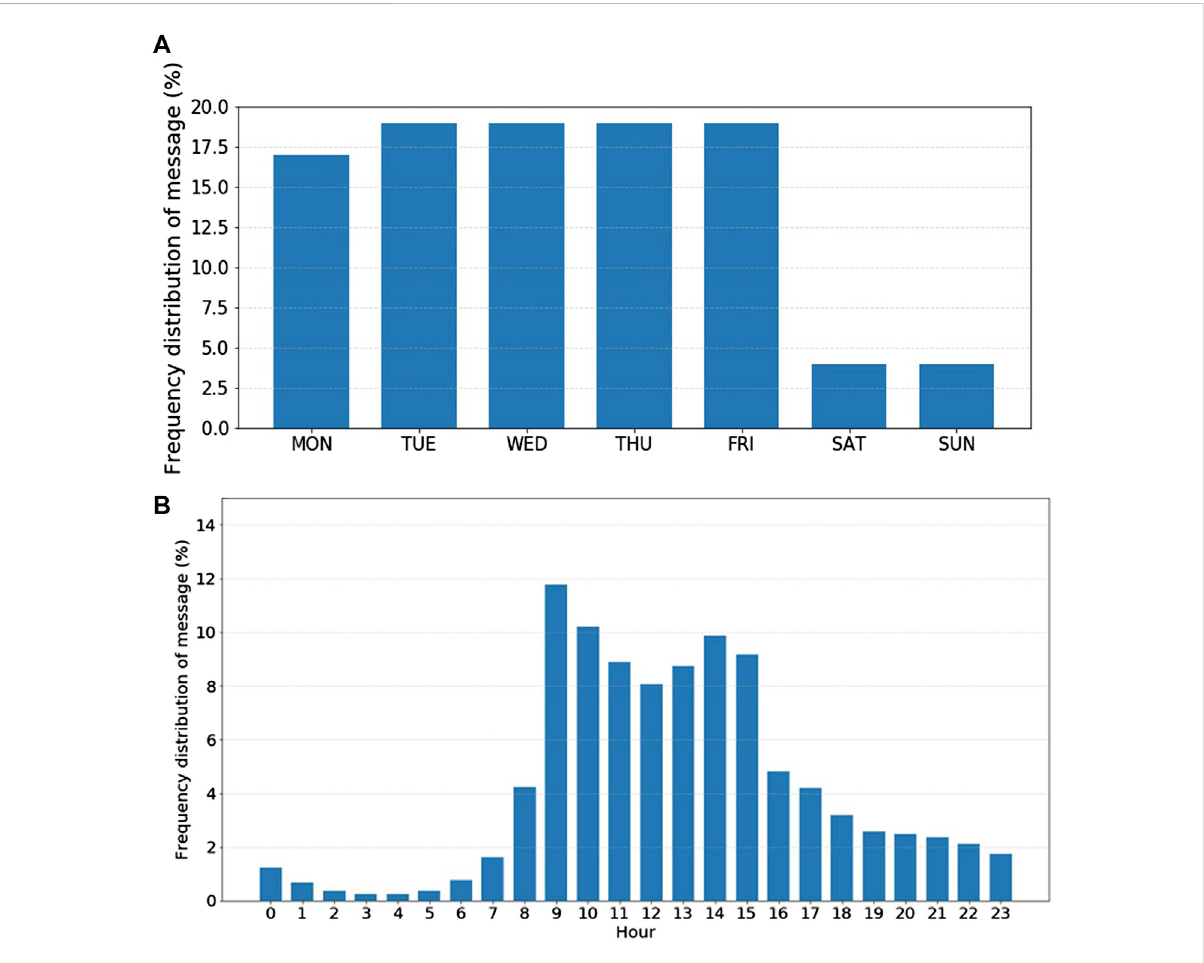
FIGURE 2 This fi gure shows the distribution of social media posts by day and time from 2018 to 2021. (A) Distribution of social media posts by day. (B) Distribution of posts by